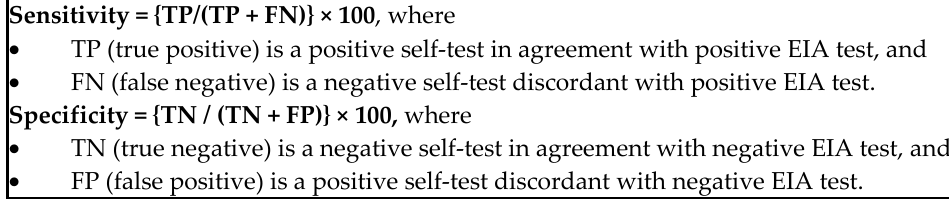
Figure 3. Sensitivity and specificity formulae.